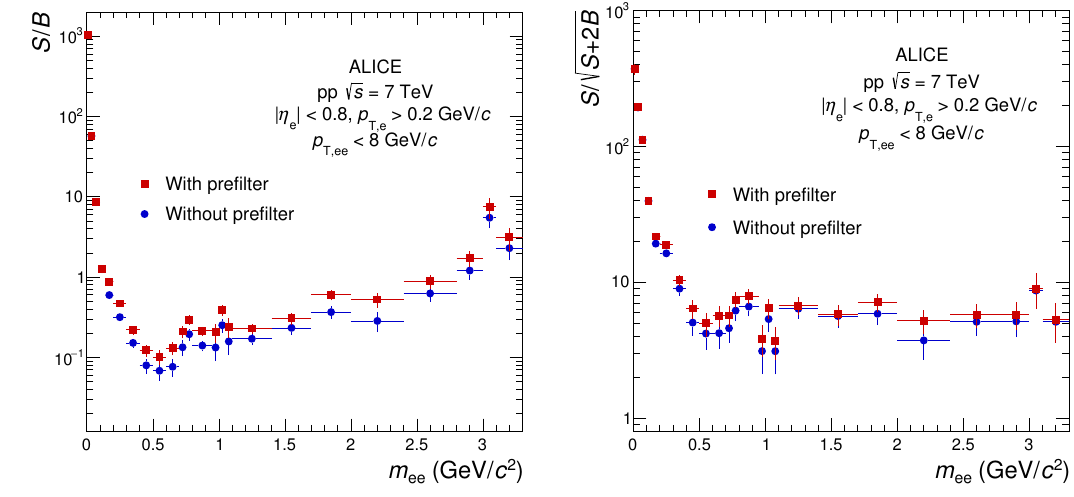
Figure 3 . Signal to background ratio (left) and signi(cid:12)cance (right) obtained with and without applying the pre(cid:12)lter. Only statistical uncertainties are shown. The background is estimated as explained in the text